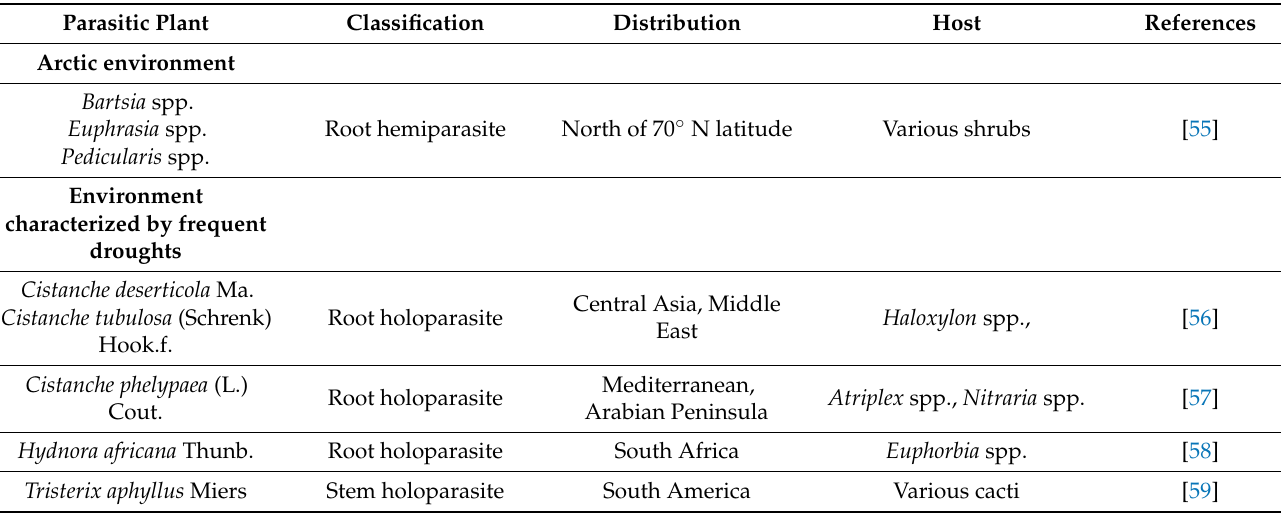
Table 1. Examples of parasitic plants and their respective hosts growing in environments characterized by abiotic stress pressure such as low temperatures, water deficiency and high soil